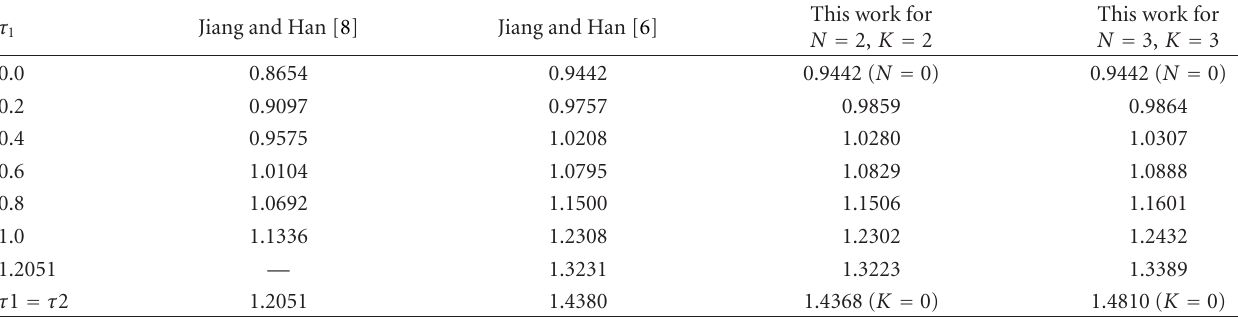
Table 3: MAUB of the time-varying delay for di ff erent μ